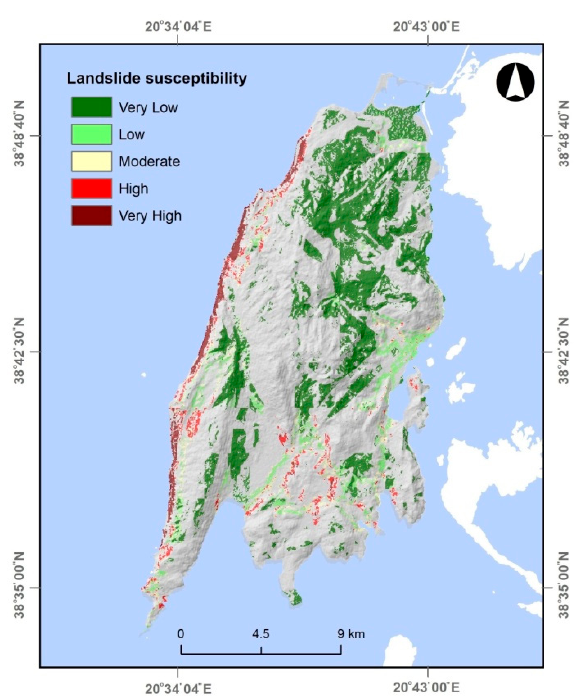
Figure 5. Map with coverage similarities between the landslide susceptibility categories of the two models.